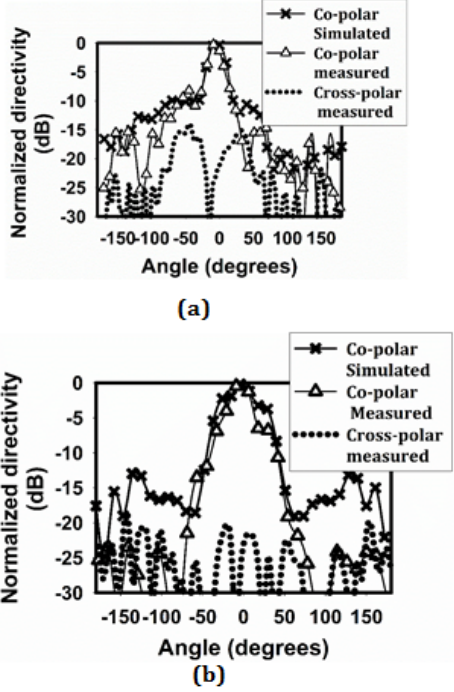
Figure.13. Radiation pattern of cavity antenna at 9.6 GHz